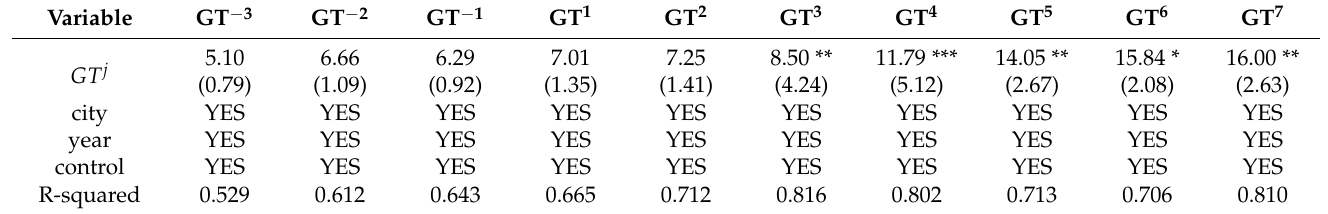
Table 9. Time effect analysis of GZR urban innovation dividend (scientific and technological